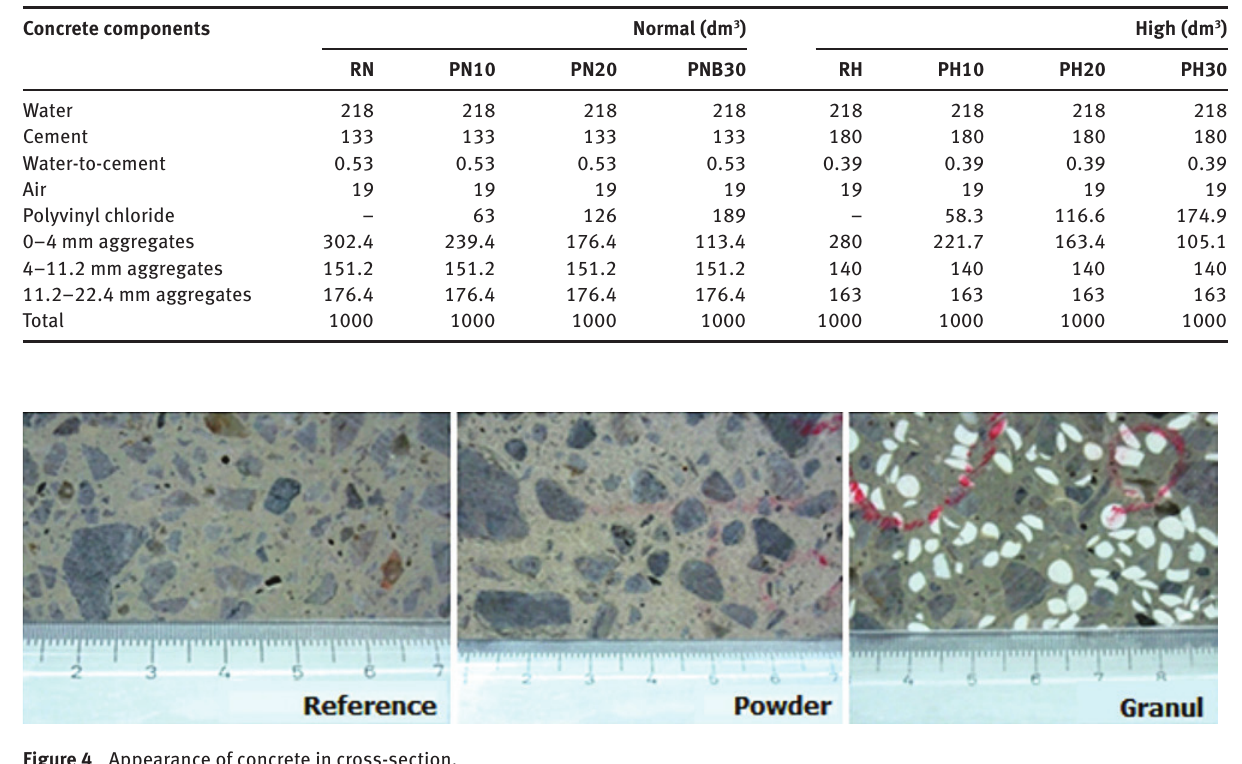
Figure 4 Appearance of concrete in